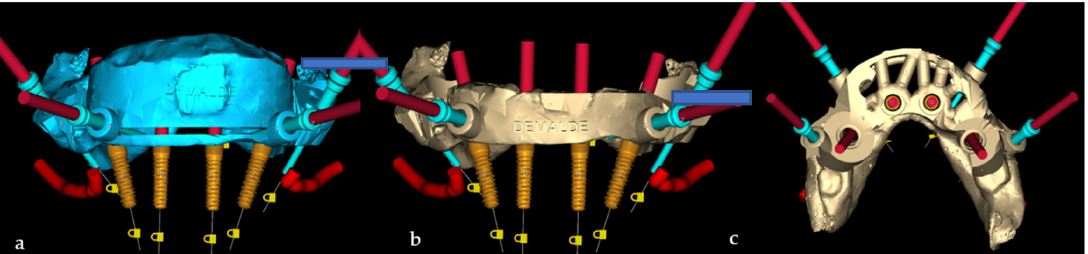
Figure 4. Implant positioning and osteotomy plan.